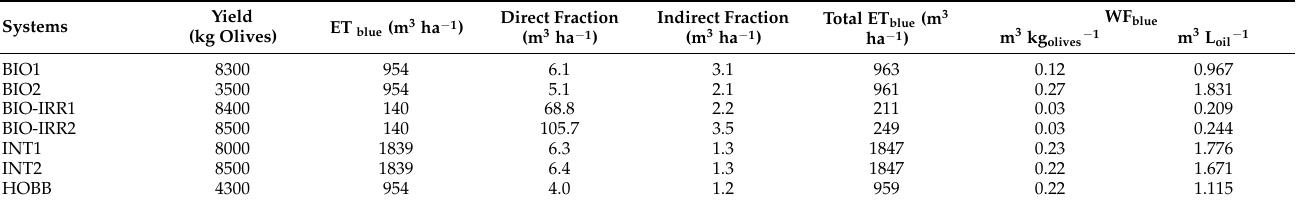
Table 6. Blue Water Footprint (WF blue ) of the analyzed systems. (ET blue : evapotranspiration; Direct fraction: the water used in the treatments, irrigation, and milling process; Indirect fraction: the water used in the manufacture of the different inputs